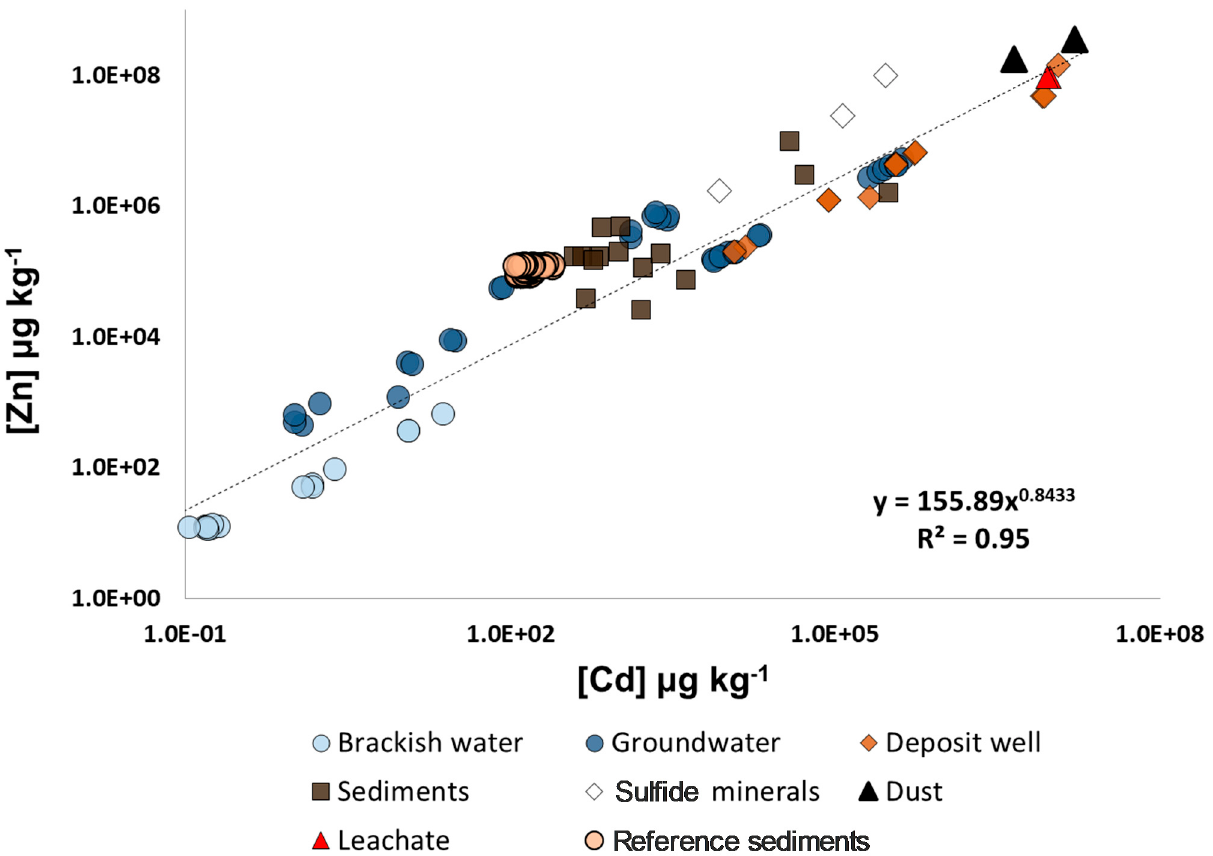
Figure 3. Correlation between Zn and Cd in ore concentrates, dusts, leachate, deposit well water, groundwater, and brackish water. Reference sediments from the Bothnian Bay (n > 65, the 1.0–5.8 m section of a 5.8 m deep sediment core from the open Bothnian Bay [50]).